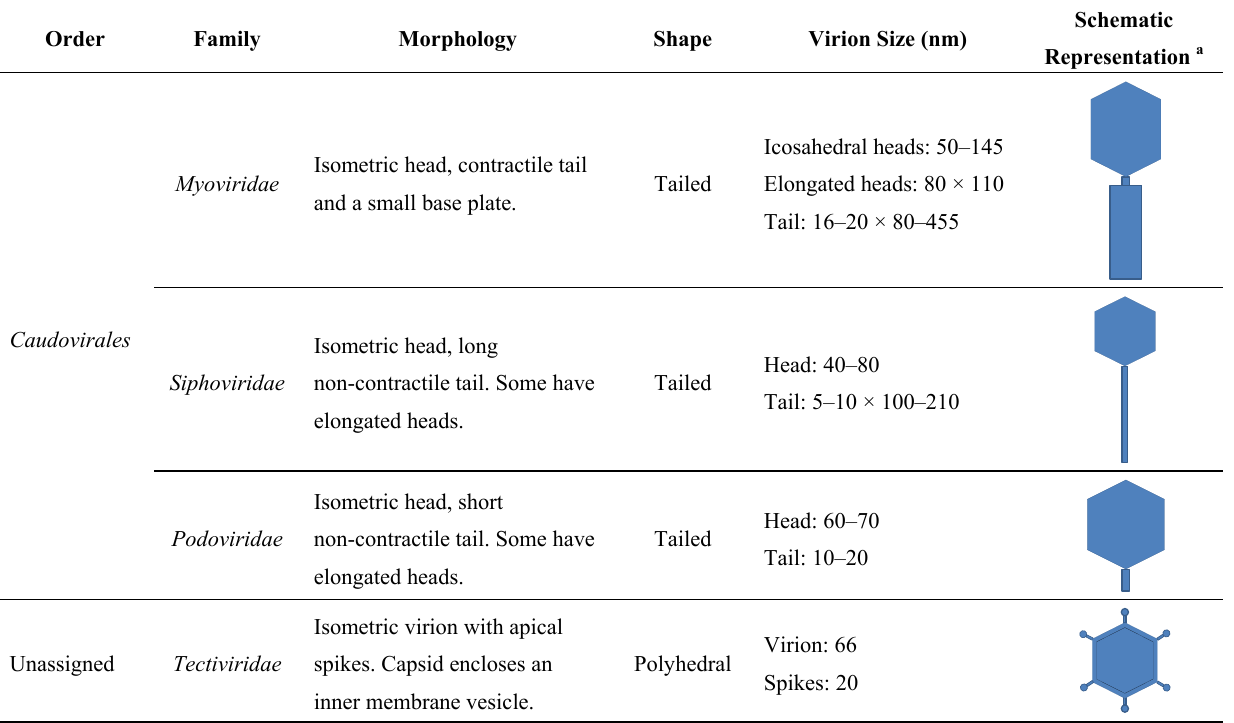
Table 2. Characteristics of the phage families infecting B. anthracis , B. cereus and B. thuringiensis . Order Family Morphology Shape Virion Size (nm)